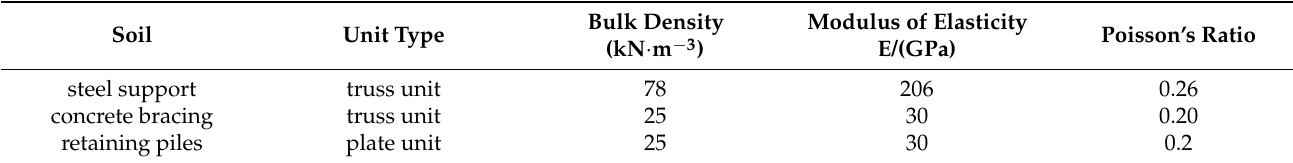
Table 4. Structural material